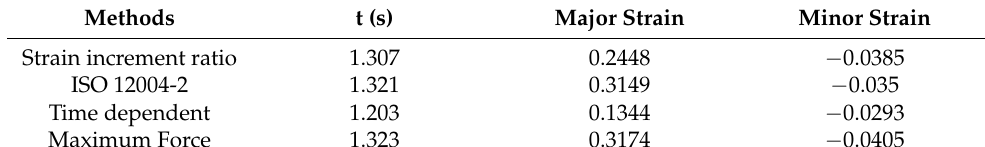
Figure 7. Mises effective strain distribution of the specimen corresponding to different critical times.